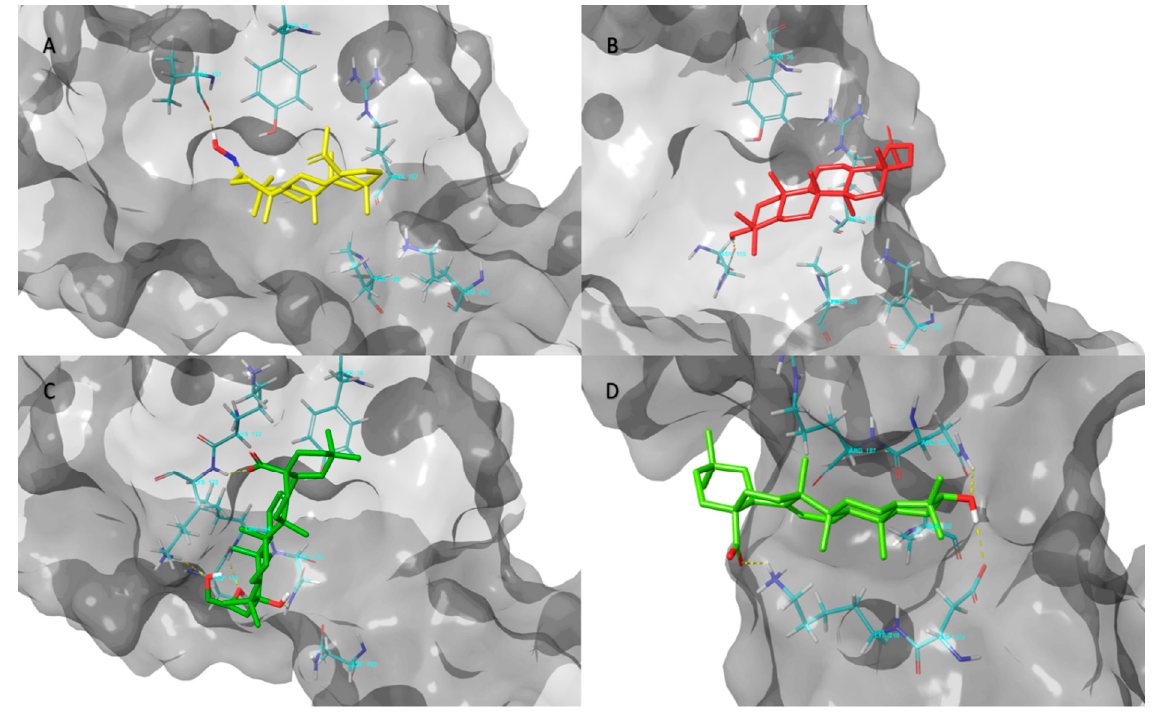
Figure 5. Ligands interactions with the p65 chain A residues. The yellow dashed lines represent the H-bonds interactions, and the light blue residues represent positive vdW contacts with the ligands. 11 ( A ), 9 ( B ), 5 ( C ) and 1 ( D ).